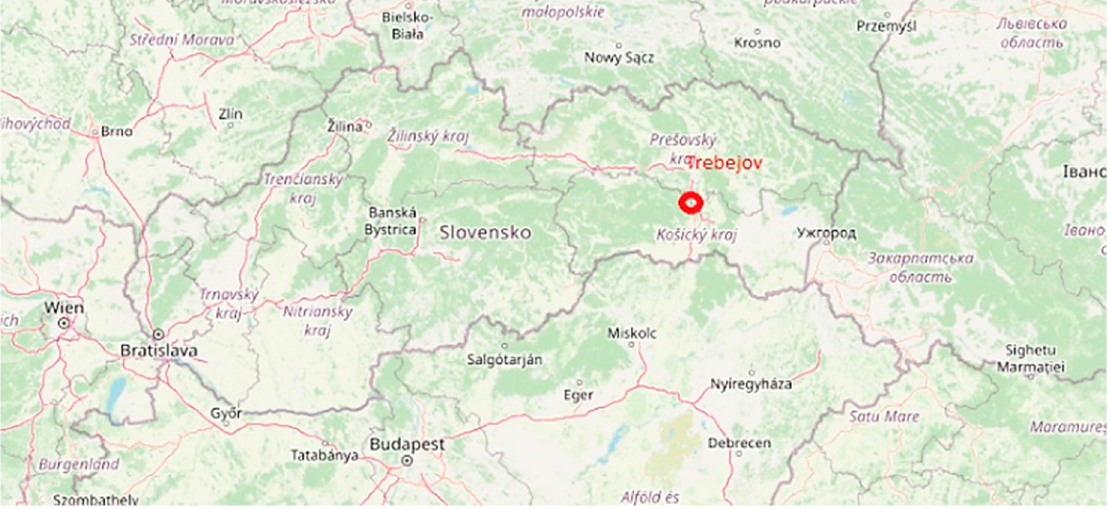
Figure 3. Demonstration of a quarry on the map of the Slovak Republic